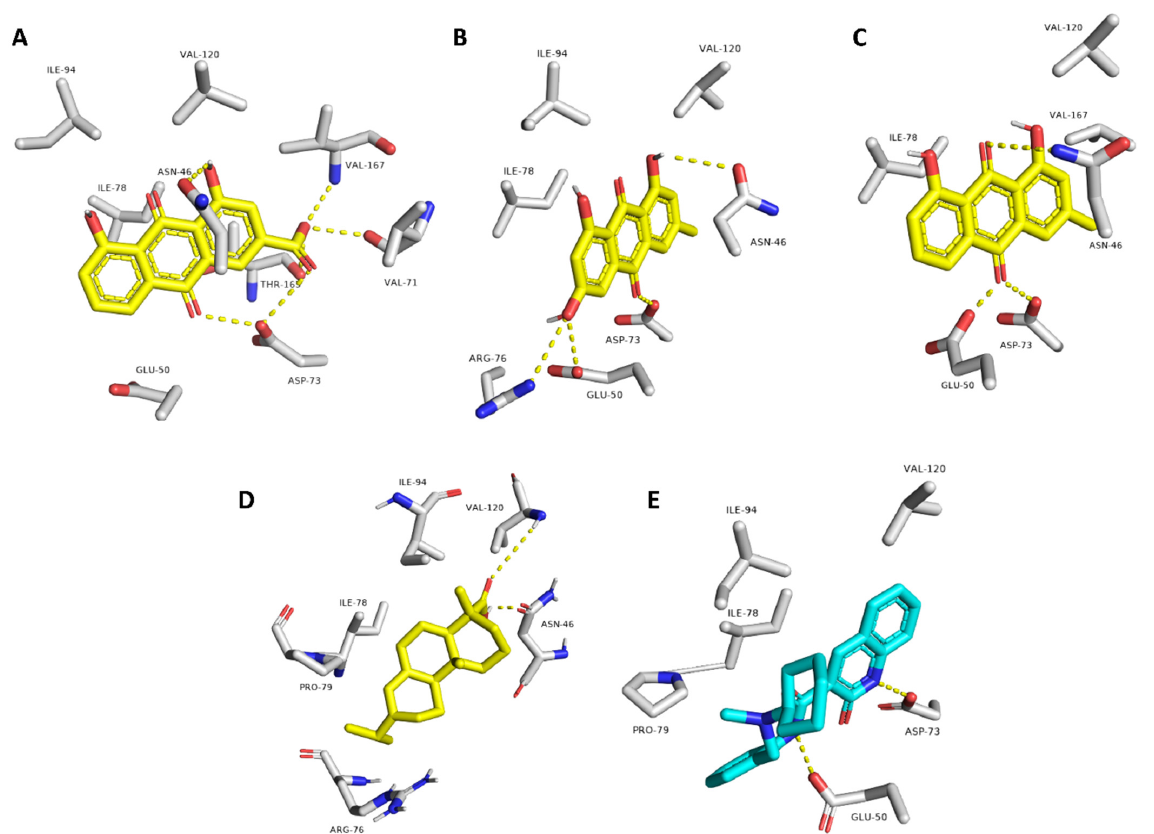
Figure 5. Binding modes of the active top-scoring hits (i.e., rhein, emodin, chrysophanol, physcion, anthrarufin, aloin; brick red-colored structures; ( A – F ), respectively) the co-crystalized ligand, D-cyclo- serine (orange-colored structure; ( G )) inside the active site of Ddl-B. These binding modes were derived from the MDS experiments (i.e., the last snapshots of the 50 ns trajectories).